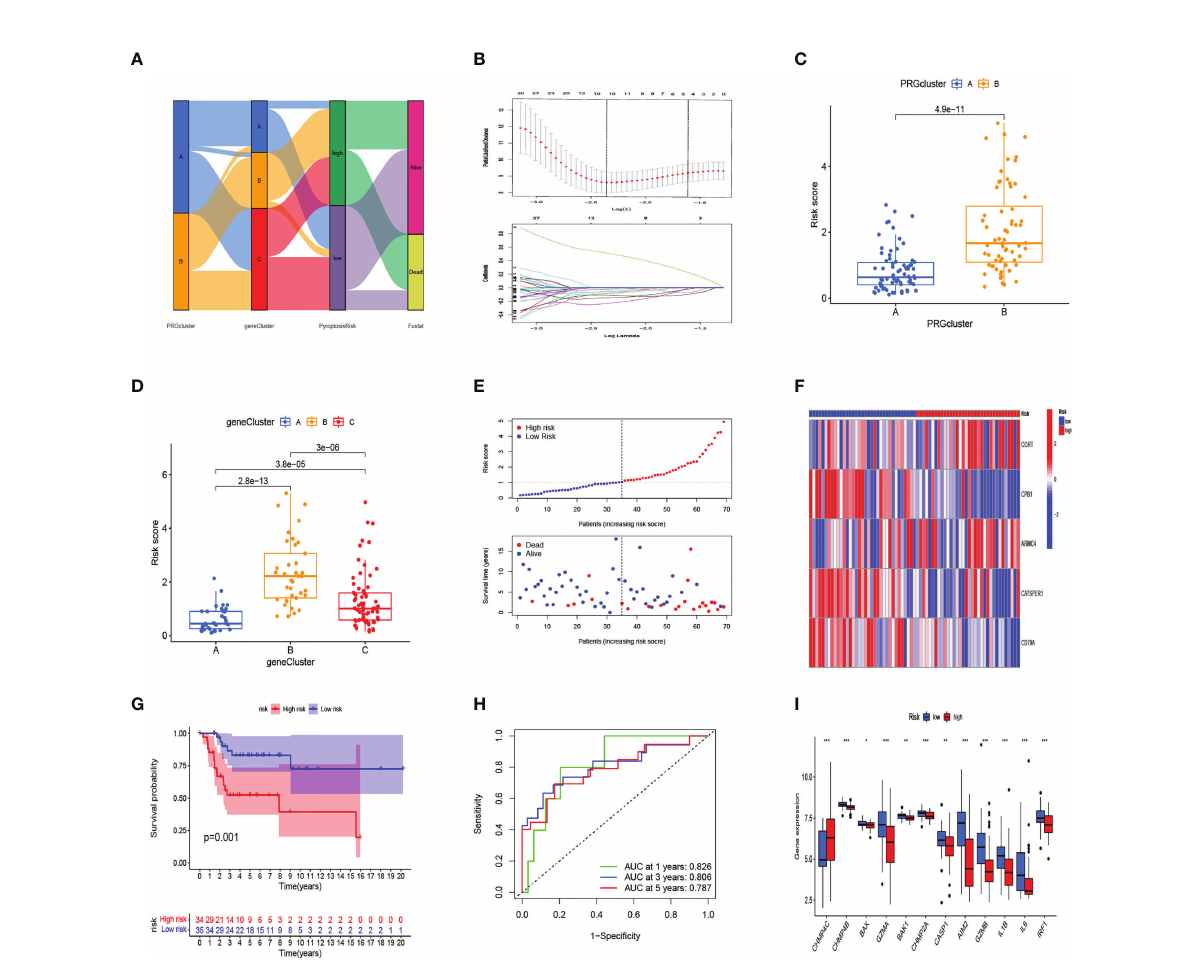
FIGURE 4 In the training set, generation of PRG_score to predict patient survival. (A) Alluvial diagram of pyroptosis-related clusters in groups with different geneClusters, PRG_score, and overall survival. (B) The minimal standard was used in the LASSO – Cox model to obtain the value of the super parameter via 10-fold cross-validation. (C) The differences in PRG_score between PRGclusters. (D) The differences in PRG_score between geneClusters. (E) Ranked dot and scatter plots showing PRG score distribution and survival status. (F) The expression heatmap of the fi ve-gene signature in the training group. (G) Kaplan – Meier analysis of the survival between the high- and low-risk groups. (H) The prognostic accuracy of the risk scores in the training group was veri fi ed by the ROC curve. (I) Expression of PRGs in the high- and low-risk groups. (***:p value <0.001, **:p value <0.01,*:p value <0.05) PRG, pyroptosis-related gene; ROC, receiver operating